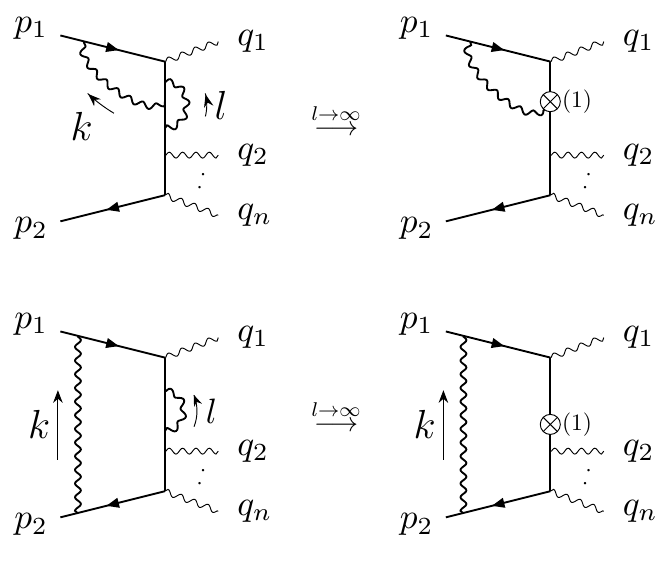
Figure 18. Illustration of ultraviolet counterterms, as defined in eq. (3.37) and (3.38), for one-loop vertex and self energy subgraphs in regular diagrams (as opposed to type S and type V